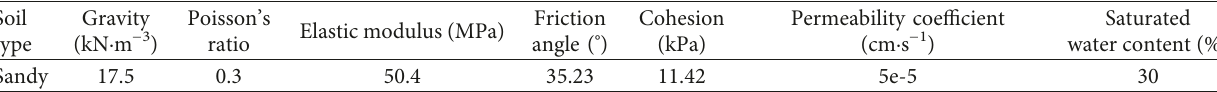
Table 1: Calculation parameters of the model.